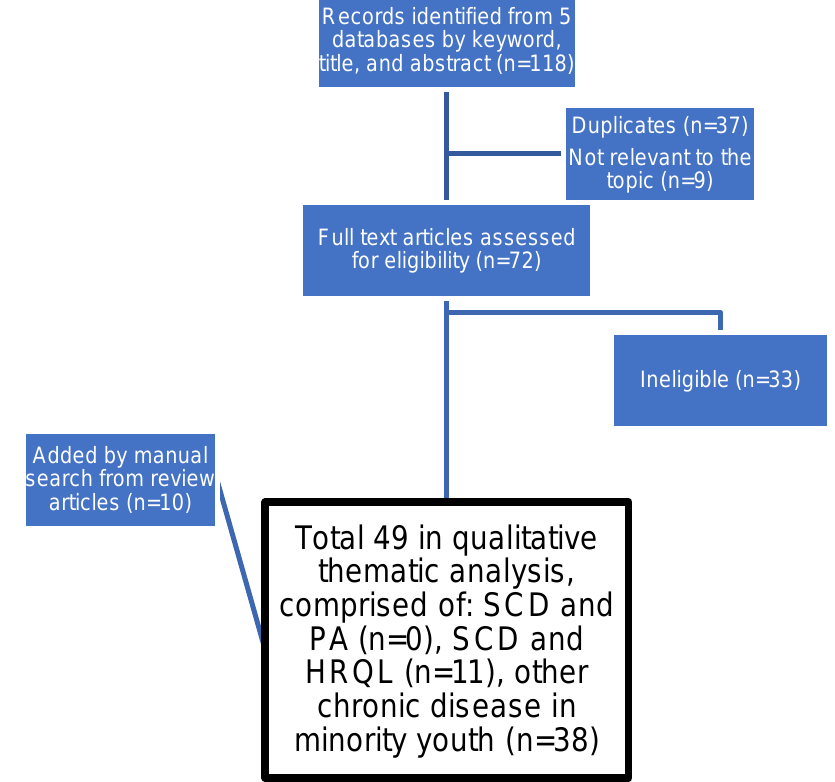
Figure 1. PRISMA flowchart of the literature search and screening.